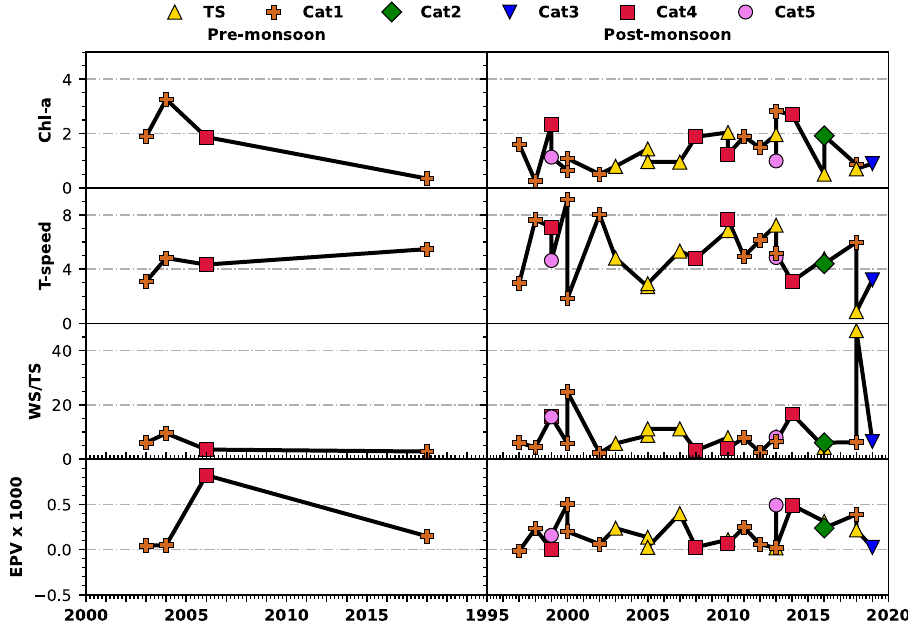
Fig. 2 The cyclone-induced Chl-a in BoB. The observed enhancement in Chl-a (mg/m 3 ) following the cyclone passage (5-day average) in the post and pre-monsoon seasons in BoB. The translational speed of the closest track points where the bloom occurred in (m/s), the ratio of wind speed to translational speed (WS/TS), and EPV (Ekman Pumping Velocity) as the cyclones reach their maximum intensity (m/s) are also shown in the lower